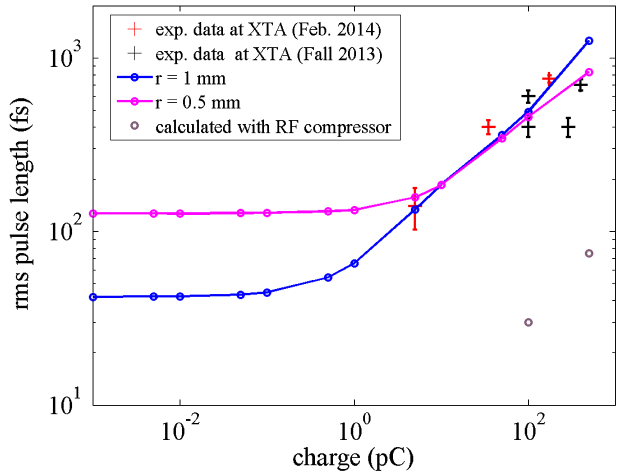
FIG. 21. Bunch lengths measured at the transverse deflector versus bunch charge, and simulated data as described in the text. Two additional simulated data points, in purple, show the bunch length when a 20-cm long RF compressor is